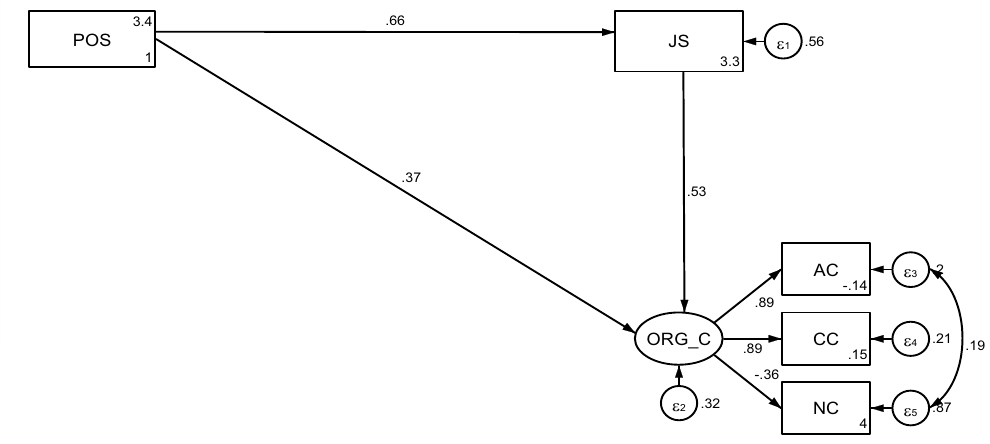
Fig. 2. Mediated relationship: